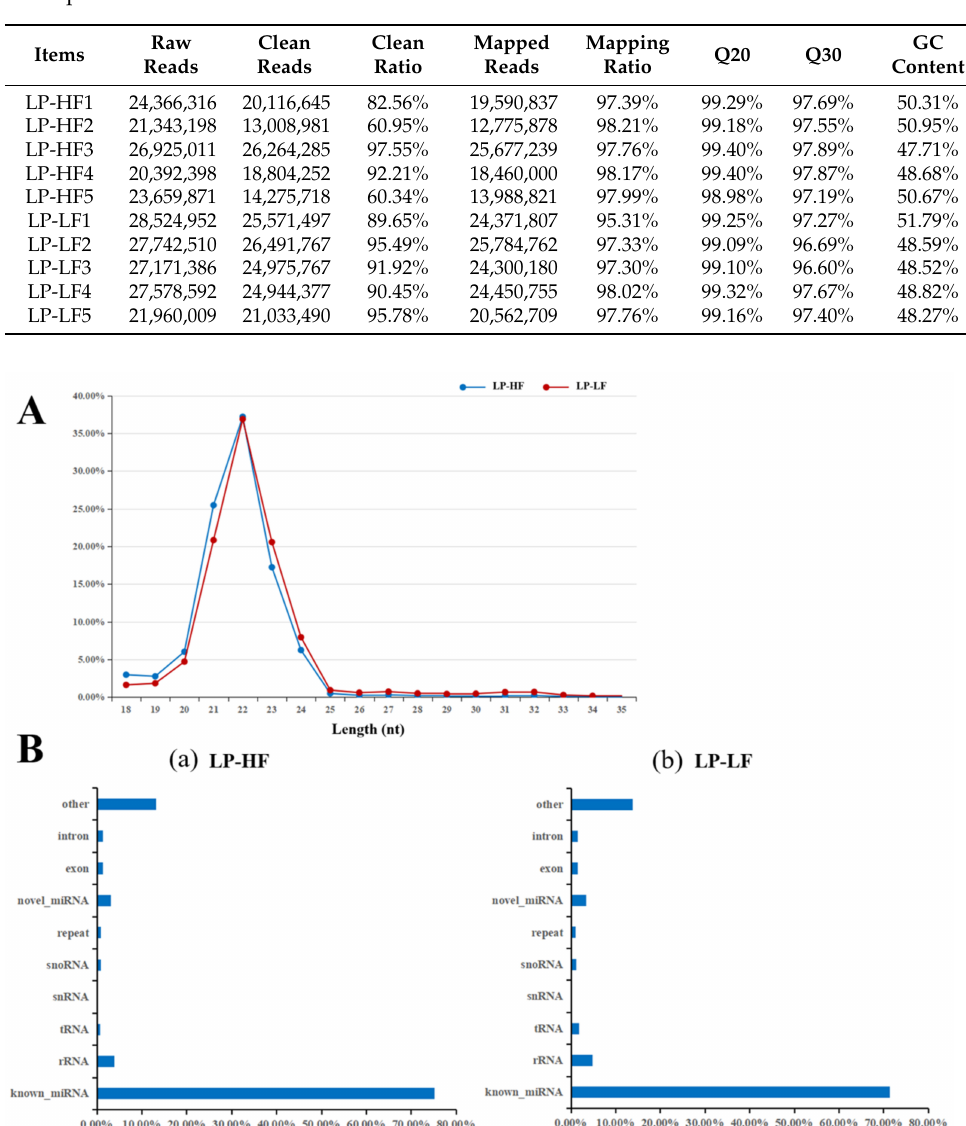
Figure 3. Length distribution of the small RNA reads and the percentage of the detected miRNAs from the non-coding RNAs (ncRNAs). ( A ) Length distribution of the clean reads from the sRNA fragments. ( B ) Categories of identified ncRNAs by sequencing in the LP-HF ( a ) and LP-LF ( b